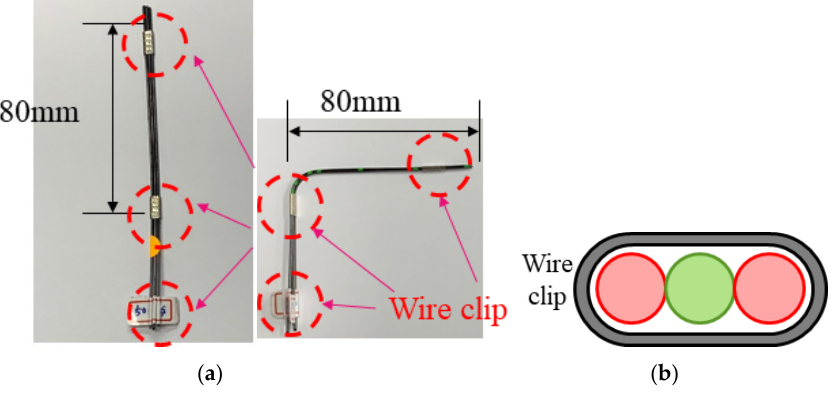
Table 2. Types of specimens.